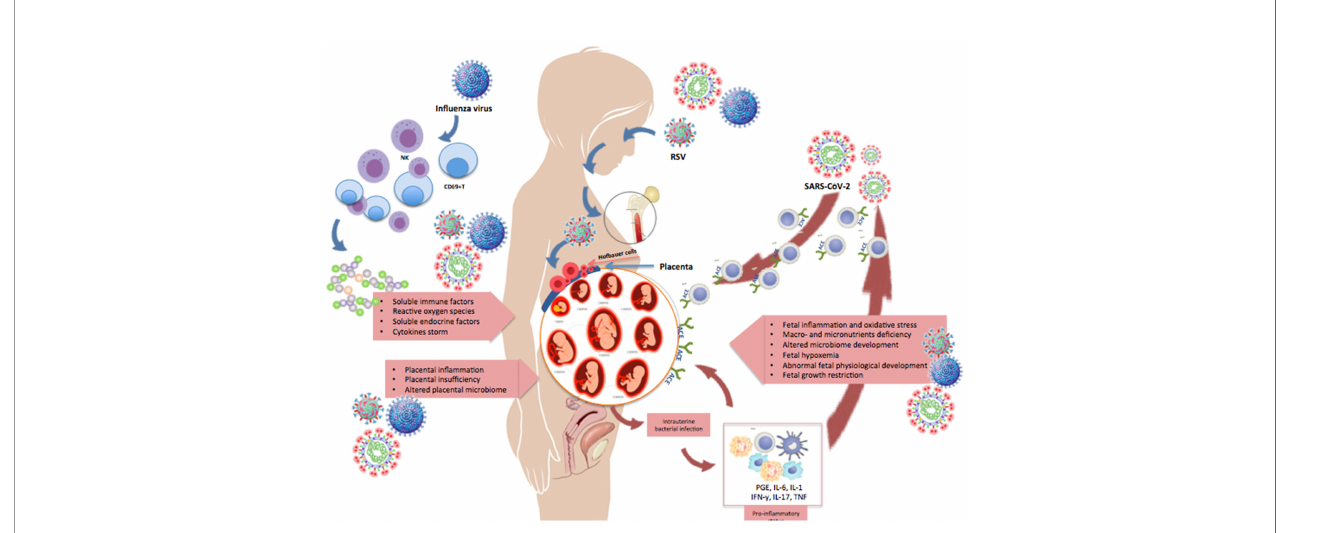
FIGURE 2 | Changes occurring in pregnancy during maternal infection. This illustration shows some of the changes occurring in pregnancy during a maternal infection with in fl uenza, RSV, or SARS-CoV-2. Pregnant women may develop an explosive in fl ammatory response to the virus (cytokine storm), which is characterized by signi fi cant increase in NK- and T-cells, CD69+ lymphocytes, and expression of pro- and anti-in fl ammatory cytokines and chemokines. Moreover, the virus can spread from the maternal respiratory tract via the bloodstream and reach the placenta and amniotic fl uid, causing chorioamnionitis with degeneration of the vascular endothelium, placental trophoblasts, decidual and amniotic cells. The fi gure shows that viral antigens and genomic sequences can disseminate to bone marrow stromal cells and other extrapulmonary tissues, like the placenta. Receptors necessary for viral entry (e.g., ACE2) have also been detected on placental cells, supporting the possibility of maternal-fetal transmission of respiratory